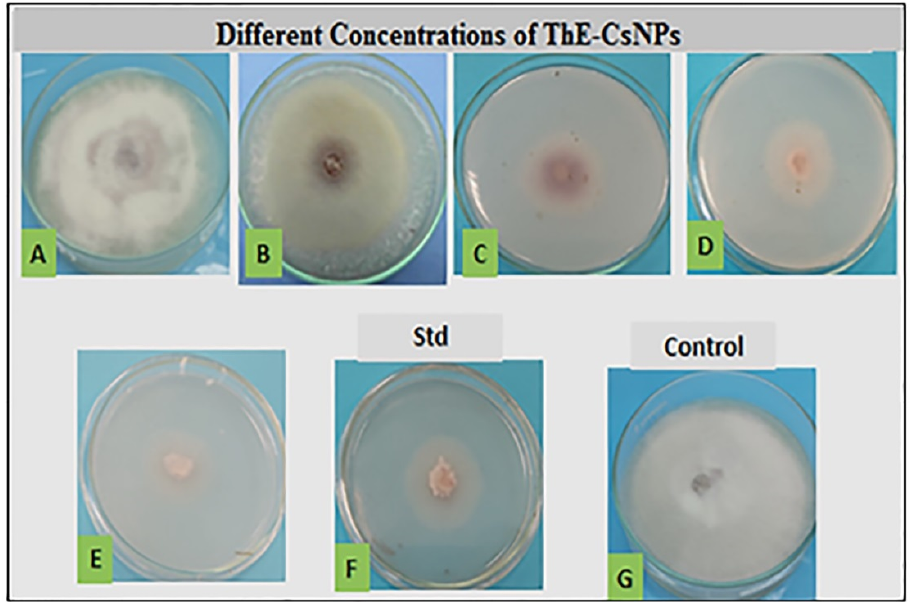
Figure 2. The antifungal activity of ThE-CsNPs at different concentrations against F. solani . Where ( A ) 0.2, ( B ) 0.4, ( C ) 0.6, ( D ) 0.8, ( E ) ThE-CsNPs (1%), ( F ) nystatin (0.05%), and ( G ) negative control.